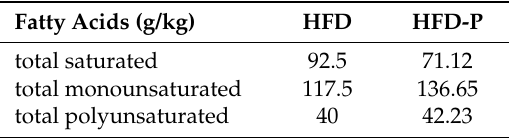
Table 2. Fatty acids composition in HFD and